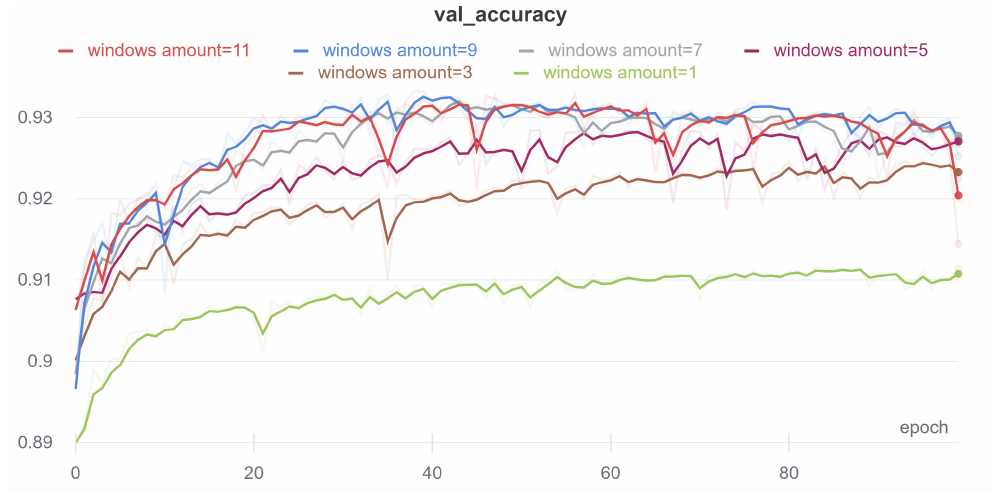
Figure 5. Smoothed learning curves showing the accuracy of the connecting model on the validation set, depending on the number of